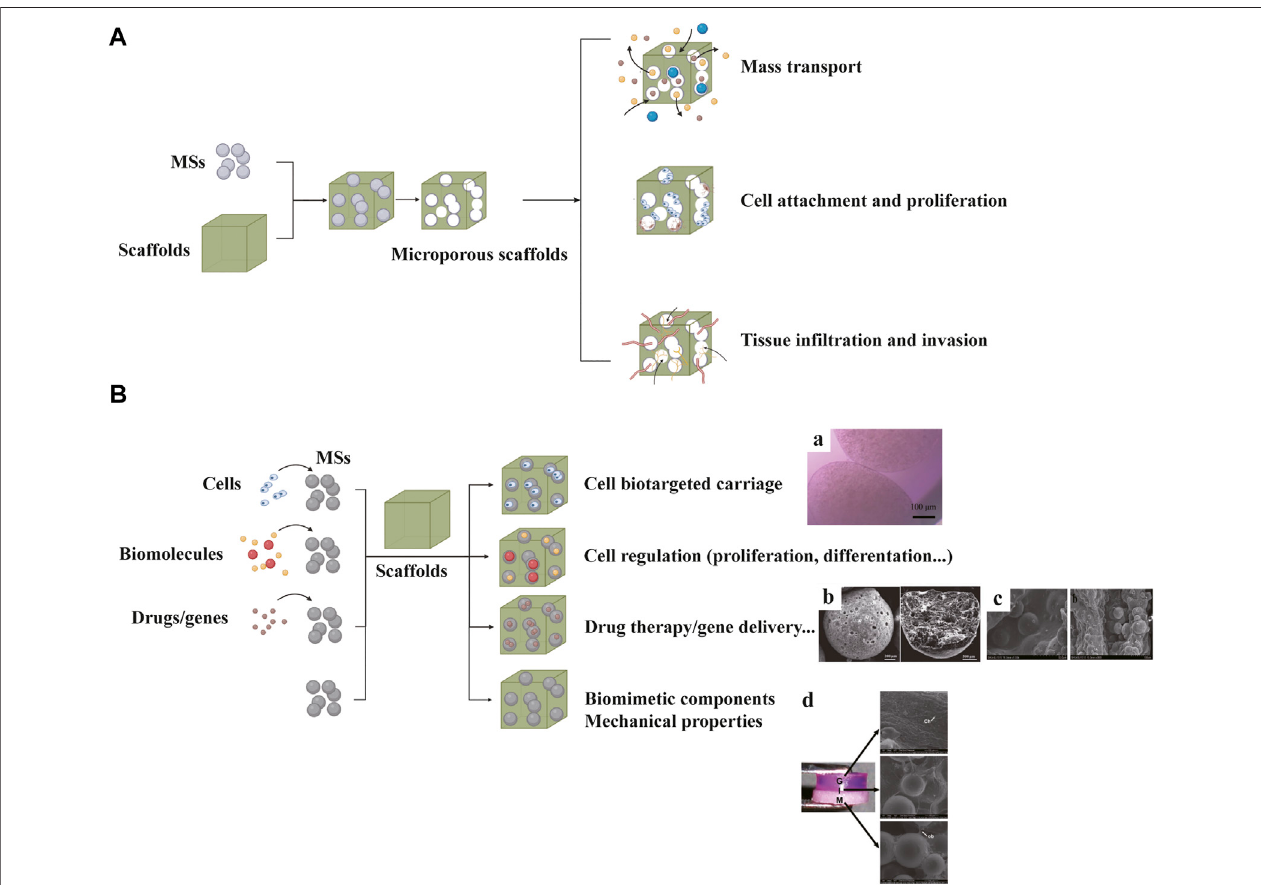
FIGURE 6 | Microsphere (MS) scaffolds can be classi fi ed into MS-leached scaffolds (A) and MS-incorporated scaffolds (B) . Chondrocyte-encapsulated MSs can provide protection and achieve targeted carriage (B: a) . MS scaffolds loaded with vancomycin hydrochloride (VH) can reduce in fl ammation after implantation (B: b) . MS scaffolds loaded with OIC-A006 (B: c) . Multi-layered scaffold consisting of pre-integrated hydrogel (G), hydrogel + microsphere interface (I) and microsphere (M) bone layers (B: d) . (B-a) Adapted with permission from ref (Bozkurt et al., 2019). Copyright 2019 by BioMed Central Ltd. (B-b) Adapted with permission from ref (He et al., 2021). Copyright 2020by Elsevier Ltd. (B-c) Adapted with permission from ref (Lin et al., 2016).Copyright 2016 by Taylor and Francis Group. (B-d) Adapted with permission from ref (Jiang et al., 2010). Copyright 2010 by Biomedical Engineering